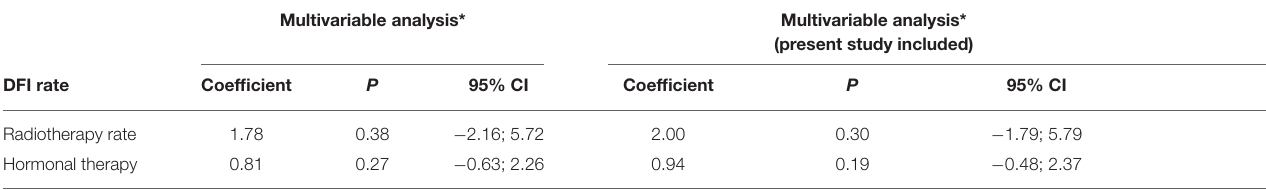
TABLE 4 | Multivariable meta-regression analysis: potential influence of radiotherapy and hormonal therapy on disease-free survival rates of tubular carcinoma at 10